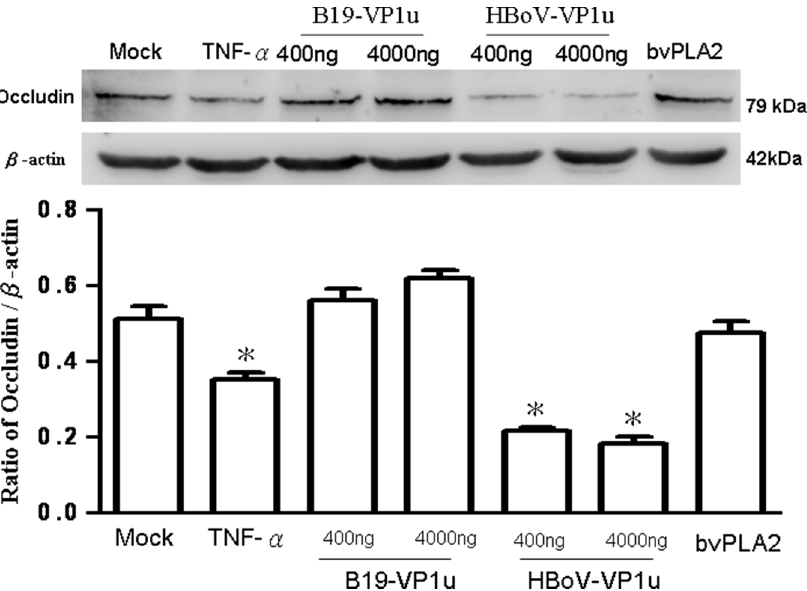
Figure 3. Expression of occludin. Cell lysates obtained from A549 cells treated with PBS (mock), TNF- a (10 ng/ml), two dosages of recombinant B19-VP1u and HBoV-VP1u (400 ng/ml and 4000 ng/ml) and bee venom PLA2 (10 ng/ml) were probed with antibodies against occludin. Quantified result was shown in the lower panel. Similar results were observed in three independent experiments and * indicates the significant difference as compared to the mock, P , 0.05.